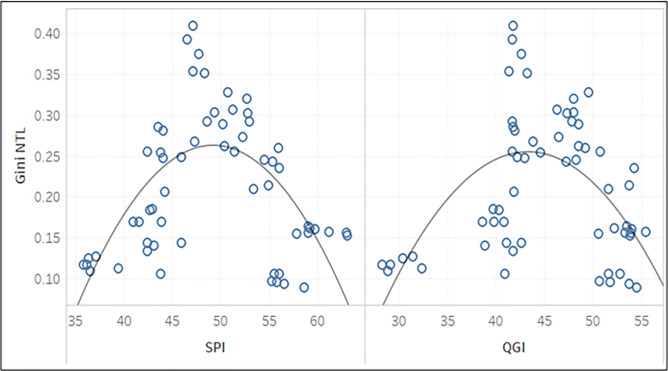
Trends between GiniNTL and SPI; GiniNTL and QGI.